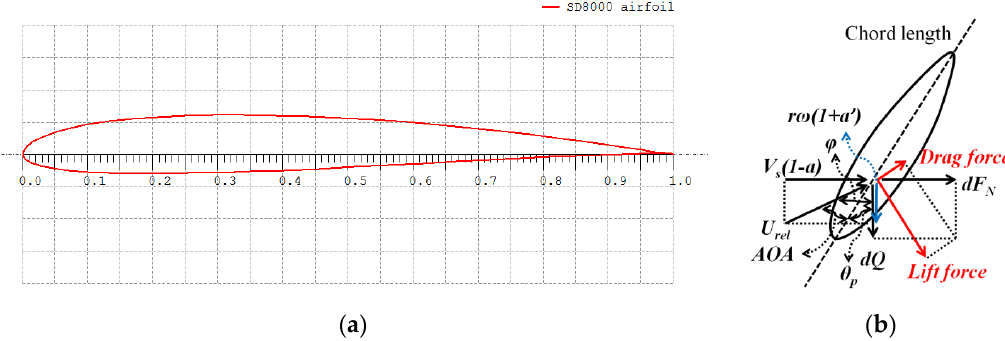
Figure 4. ( a ) Geometry of airfoil SD8000; and ( b ) BEMT angle definition for an airfoil. Table 1. The parameter of the blade.